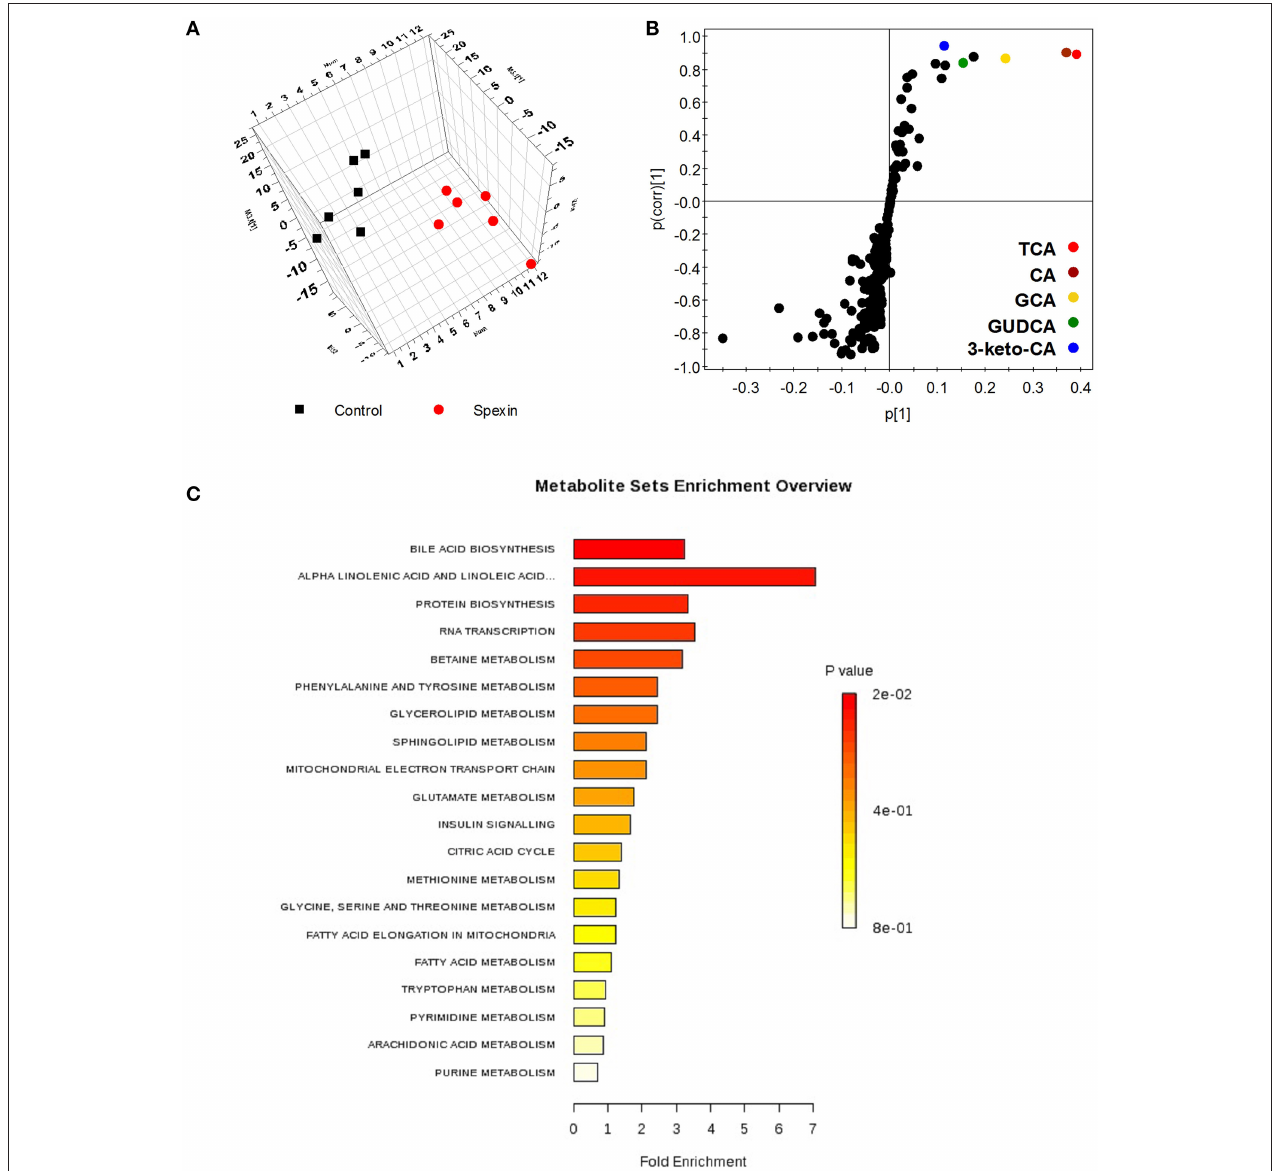
FIGURE 1 | Altered metabolic phenotype induced by spexin in rat serum metabolomic analysis resulting from UPLC/MS with negative ions mode. (A) Three dimensional PLS-DA score plot of serum metabolome from control and spexin-injected groups ( n = 6/group). The parameters of the PLS-DA model are R2X = 0.681, R2Y = 0.756, Q2 = 0.43. (B) Scatter chart of metabolic fragments in PLS-DA model reveals the contributing signals for clustering control and treated groups. Each point represents an individual fragment obtained from UPLC/MS acquisition. The labeled metabolites identified as a group of bile acids were significantly decreased by spexin intervention. (C) Altered pathway calculated based on metabolic signature in ESI − using MSEA metabolic pathway library conducting on Metaboanalyst (http:// www.metaboanalyst.ca/). Bile acid biosynthesis is the top pathway altered by spexin with highest hits and lowest p -value ( p =